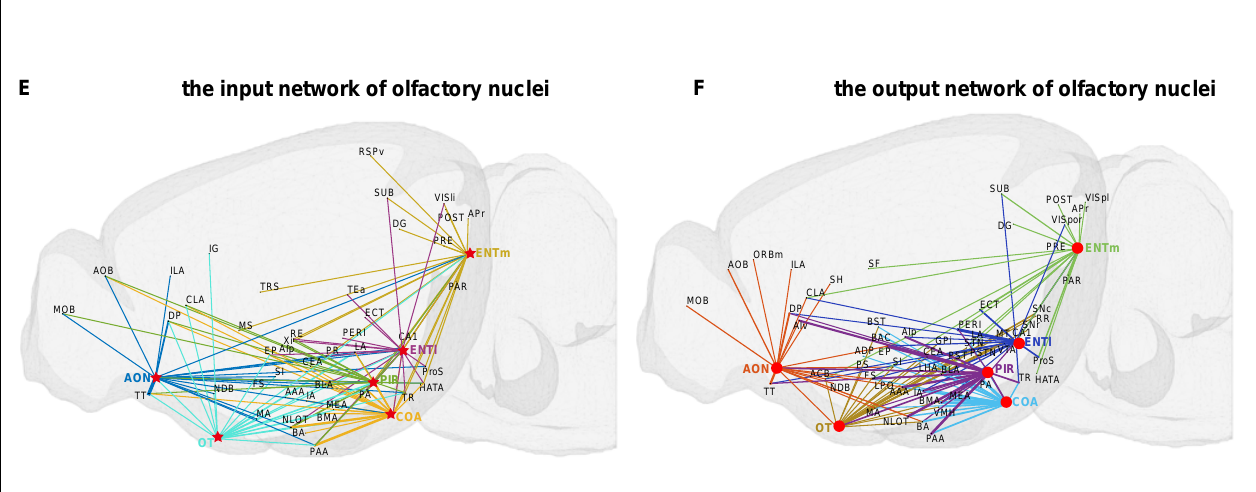
Frontiers in Neuroanatomy |